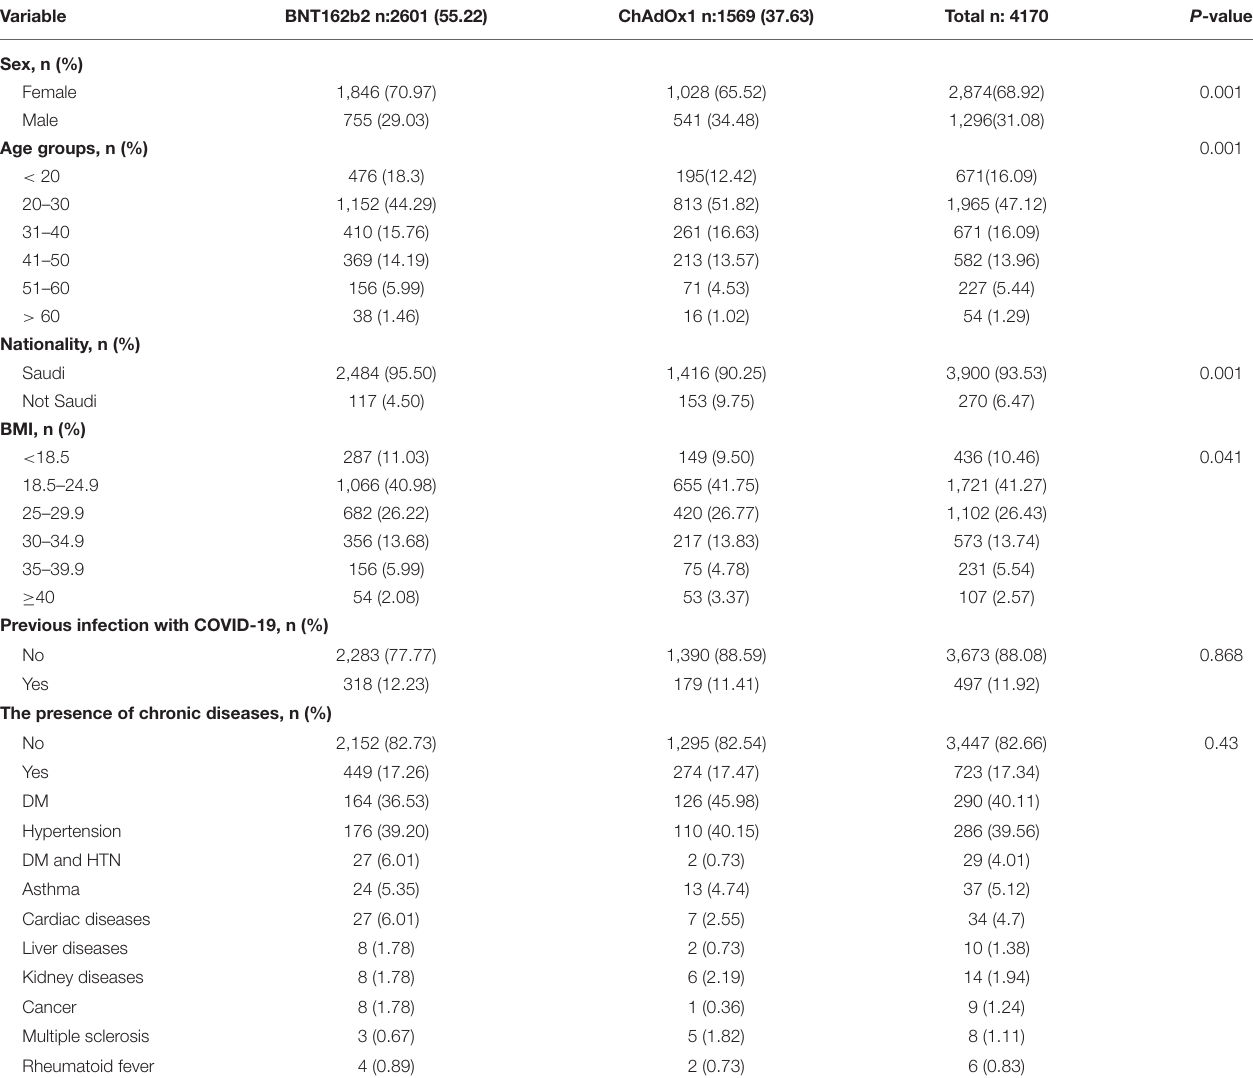
TABLE 1 | Frequencies and characteristics of the subjects in the current